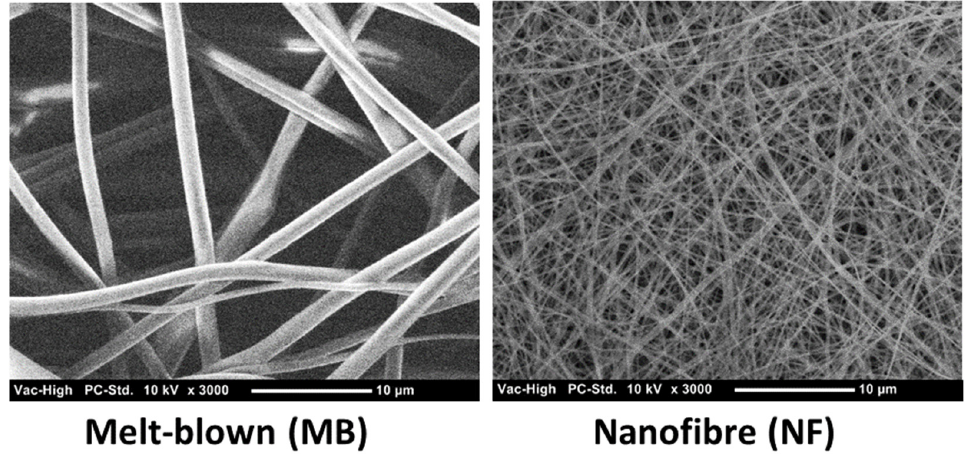
Figure 1. SEM micrographs of melt-blown fibres and ES nanofibres from FilterLayr TM